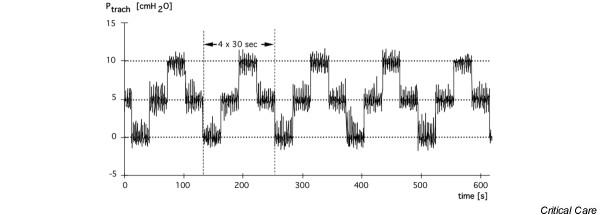
Time course of tracheal pressure during steps in PEEP. The examination was performed while the patient was breathing spontaneously at (tracheal) continuous positive airway pressure by means of the automatic tube compensation mode. Starting from 5 cmH2O, the level of PEEP was changed to 0, 5, 10 and (again) 5 cmH2O for durations of 30 s each for five consecutive runs. Note that the changes in PEEP level were in synchrony with the patient's breathing pattern (i.e. upward steps during inspiration and downward steps during expiration). PEEP, positive end-expiratory pressure; Ptrach, tracheal pressure.